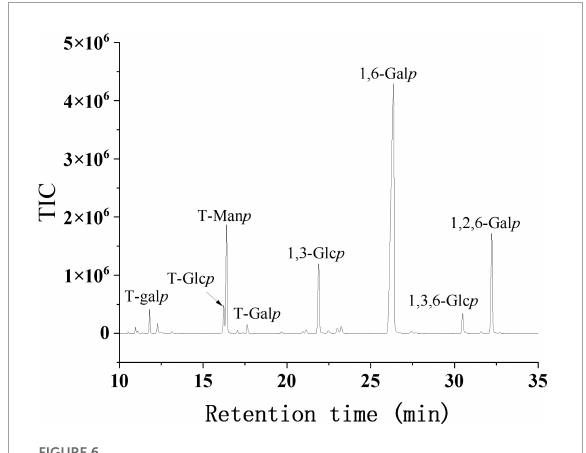
FIGURE6 The TIC profiles of the methylated alditol acetylates of SRF-3.